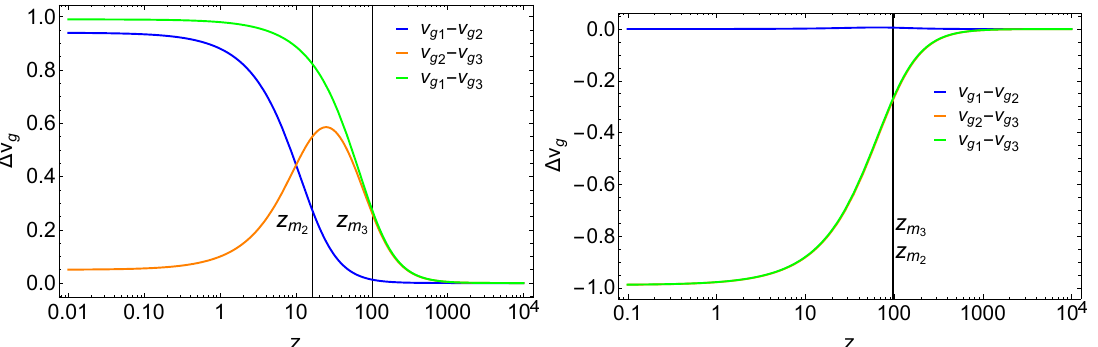
Figure 3. Difference of group velocities of neutrinos mass states for normal (left) and inverted (right) hierarchy ( m lightest = 0), shown for neutrinos at the peak of their thermal distribution ( q = 3.15 T ν ). The vertical lines mark the time of transition to the non-relativistic regime for the two massive neutrino